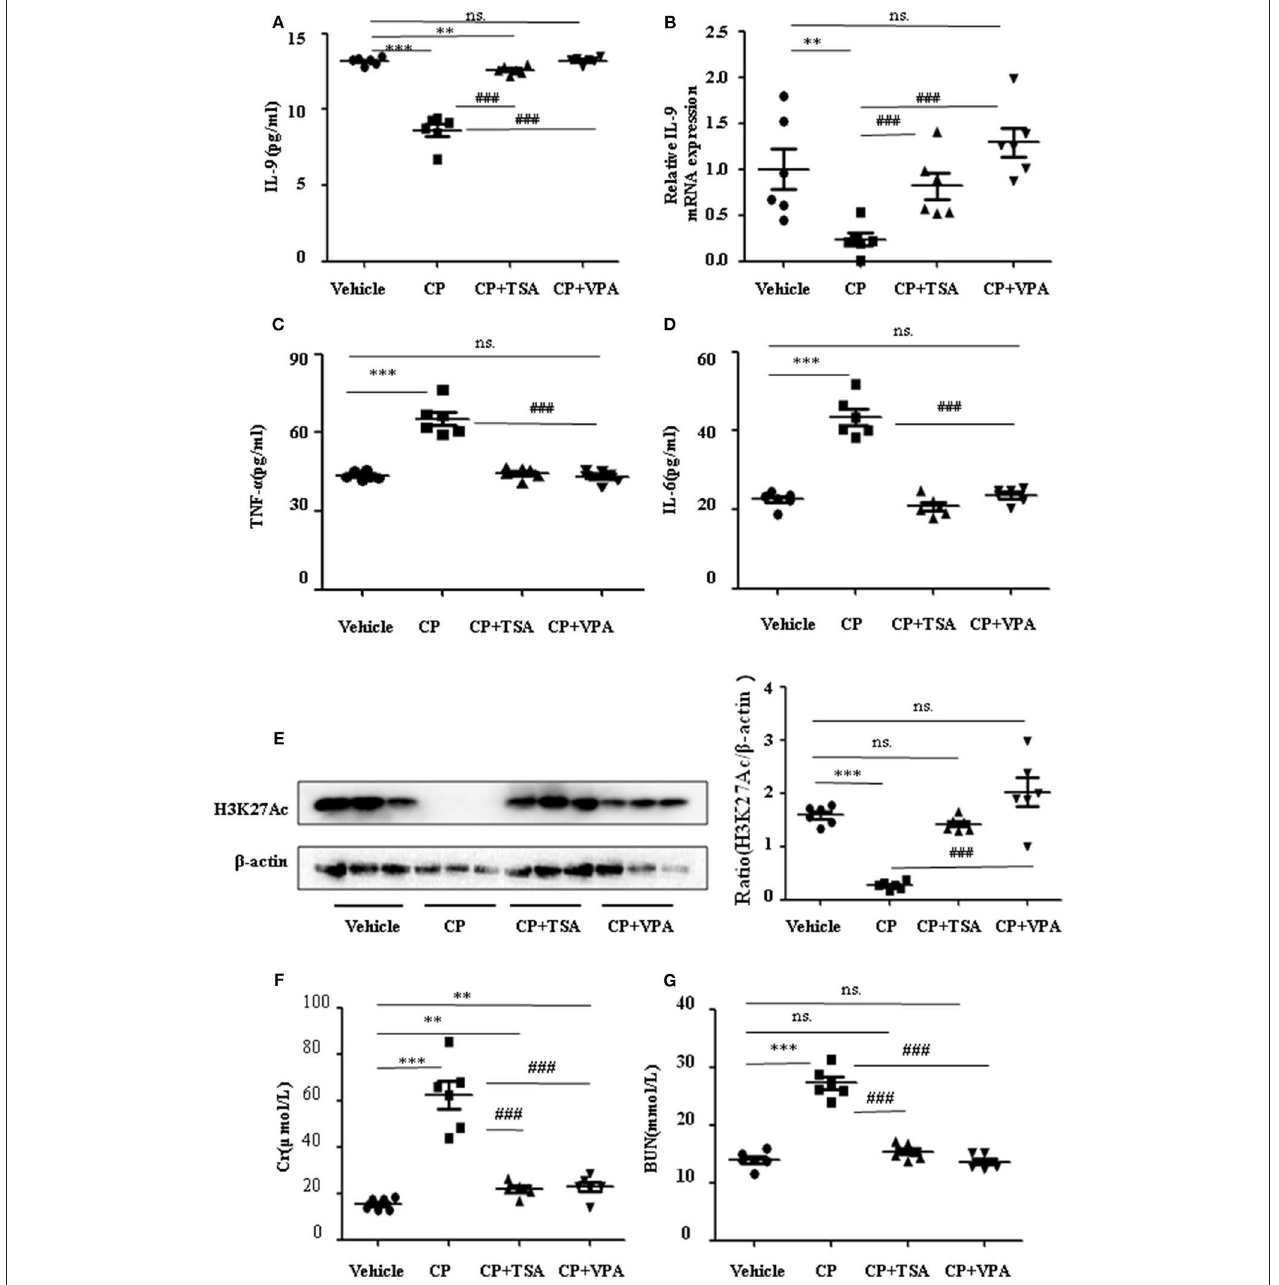
FIGURE 6 | Trichostatin A (TSA) or valproate (VPA) upregulated interleukin-9 (IL-9) with cisplatin (CP)-induced acute kidney injury (AKI) mice in vivo . Three independent experimental series were performed with six animals per group in each series. Data are represented as mean ± SD ( n = 6). (A) The level of IL-9 in CP-induced AKI mice with administration of TSA (1 mg/kg body weight) or VPA (1 mg/kg body weight), respectively, by ELISA. *** P < 0.001, ** P < 0.01 vs. the vehicle group; ### P < 0.001 vs. the CP-treated group. (B) The mRNA level of IL-9 in CP-induced AKI mice with administration of TSA (1 mg/kg body weight) or VPA (1 mg/kg body weight), respectively. Dot plots show the corresponding quantification of mRNA level and fold change. ** P < 0.01 vs. the vehicle group; ### P < 0.001 vs. the CP-treated group. (C) The levels of pro-inflammatory cytokine tumor necrosis factor- α (TNF- α ) in serum of CP-induced AKI mice with administration of TSA (1 mg/kg body weight) or VPA (1 mg/kg body weight), respectively. *** P < 0.001 vs. the vehicle group; ### P < 0.001 vs. the CP group. (D) The levels of pro-inflammatory cytokine IL-6 in serum of CP-induced AKI mice with administration of TSA (1 mg/kg body weight) or VPA (1 mg/kg body weight), respectively. *** P < 0.001 vs. the vehicle group; ### P < 0.001 vs. the CP group. (E) The protein expression of H3K27Ac in CP-induced AKI mice with administration of TSA (1 mg/kg body weight) or VPA (1 mg/kg body weight), respectively. *** P < 0.001 vs. the vehicle group. (F) Changes in serum creatinine (Cr) level with CP-induced AKI mice with administration of TSA (1 mg/kg body weight) or VPA (1 mg/kg body weight), respectively. *** P < 0.001, ** P < 0.01 vs. the vehicle group; ### P < 0.001 vs. the CP group. (G) Changes in serum blood urea nitrogen (BUN) level with CP-induced AKI mice with administration of TSA (1 mg/kg body weight) or VPA (1 mg/kg body weight), respectively. *** P < 0.001 vs. the vehicle group; ### P < 0.001 vs. the CP group.